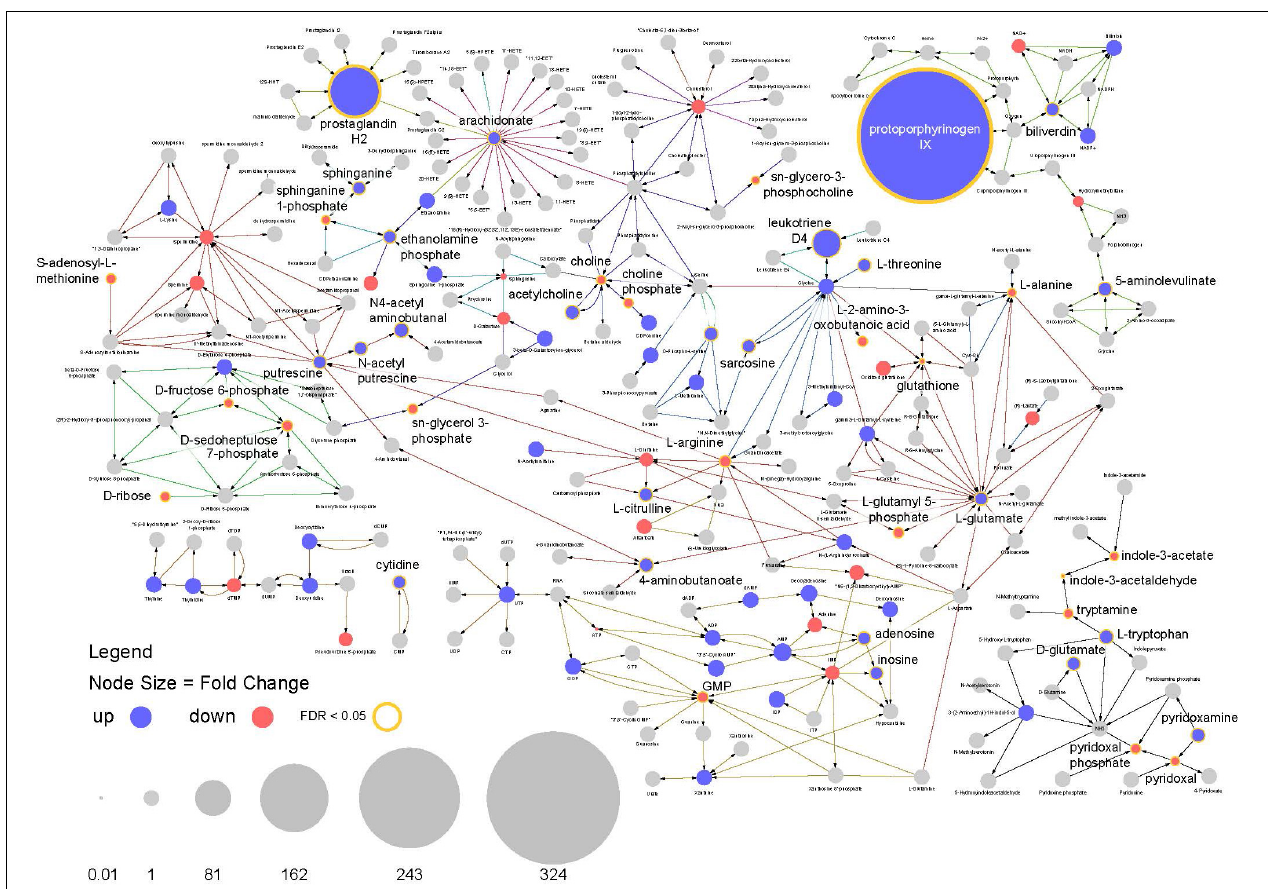
FIGURE 8 | Pathway analysis. Visualization of relative compound abundances and statistical significance from pathways identified by pathway enrichment analysis. Points represent individual compounds. Blue points are more abundant in ZIKV infected mosquitoes and red points are less abundant. Point sizes represent the fold change relative to uninfected mosquitoes. Yellow borders around points and increased label font size represent significant changes in compound abundance (FDR < 0.05). Arrows represent enzyme mediated conversions of one compound to